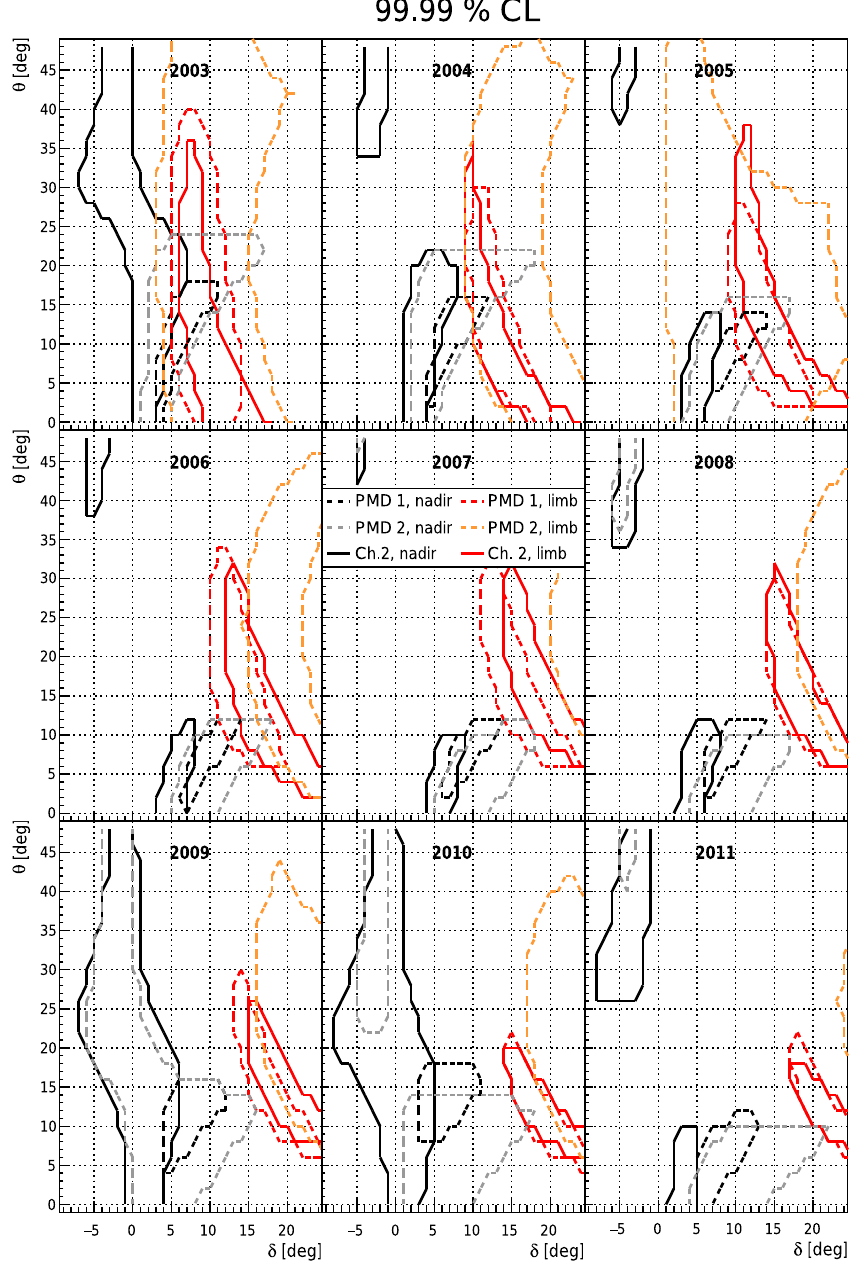
Figure 14. The 99.99% confidence region contours for limb and nadir, PMDs 1 and 2, and channel 2 for each year starting from 2003 (top left) to 2011 (bottom